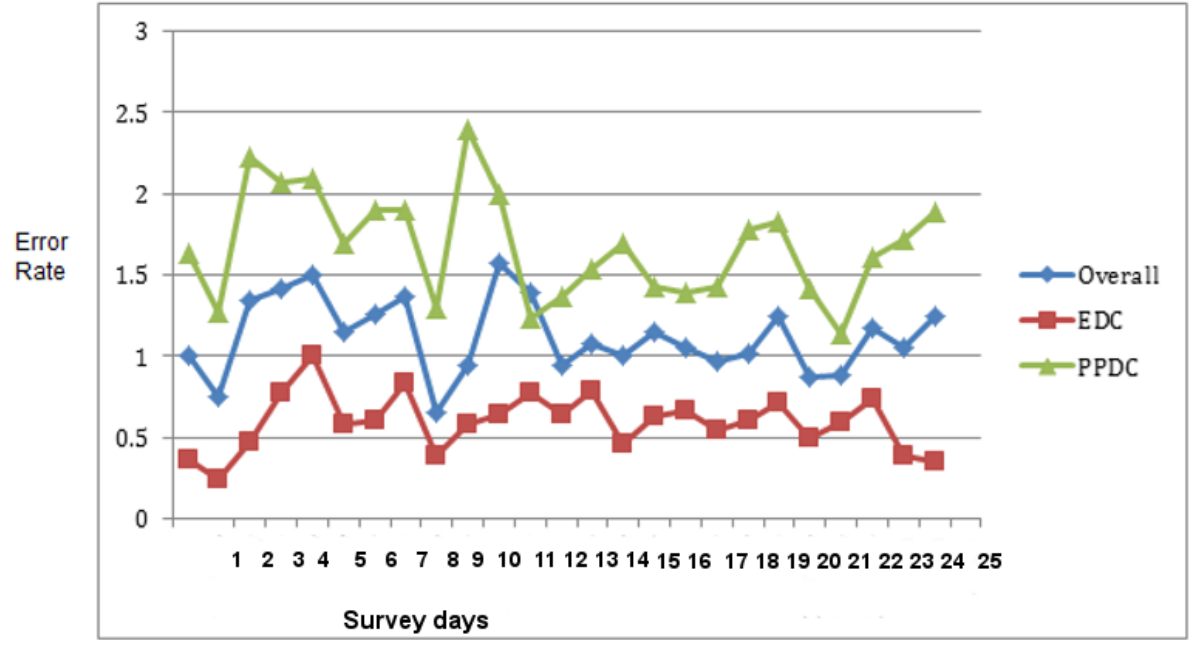
Figure 3. Mean values of the overall error rates trend of electronics data capture tool (EDC) using tablet and paper and pen data capture (PPDC) tools used during the survey in the demographic survey site in 2016, Dabat, northwest Ethiopia.